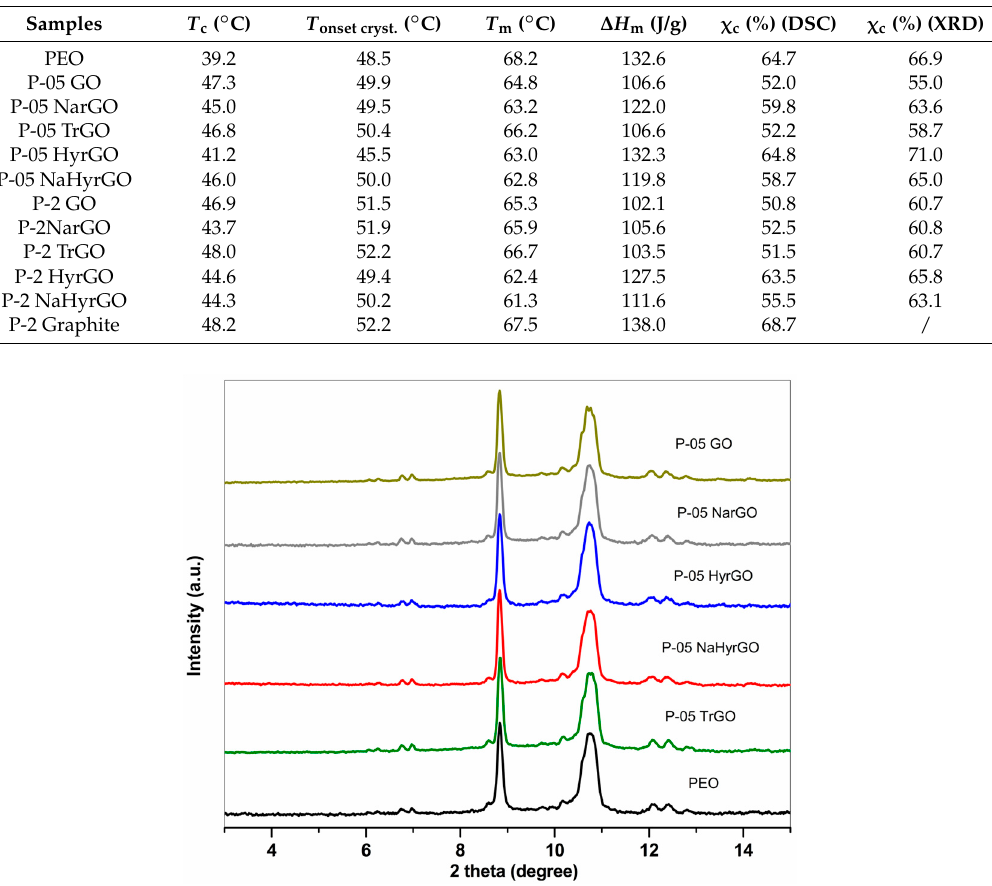
Figure 8. XRD patterns of 0.5 wt % PEO-based nanocomposites at 25 °C.